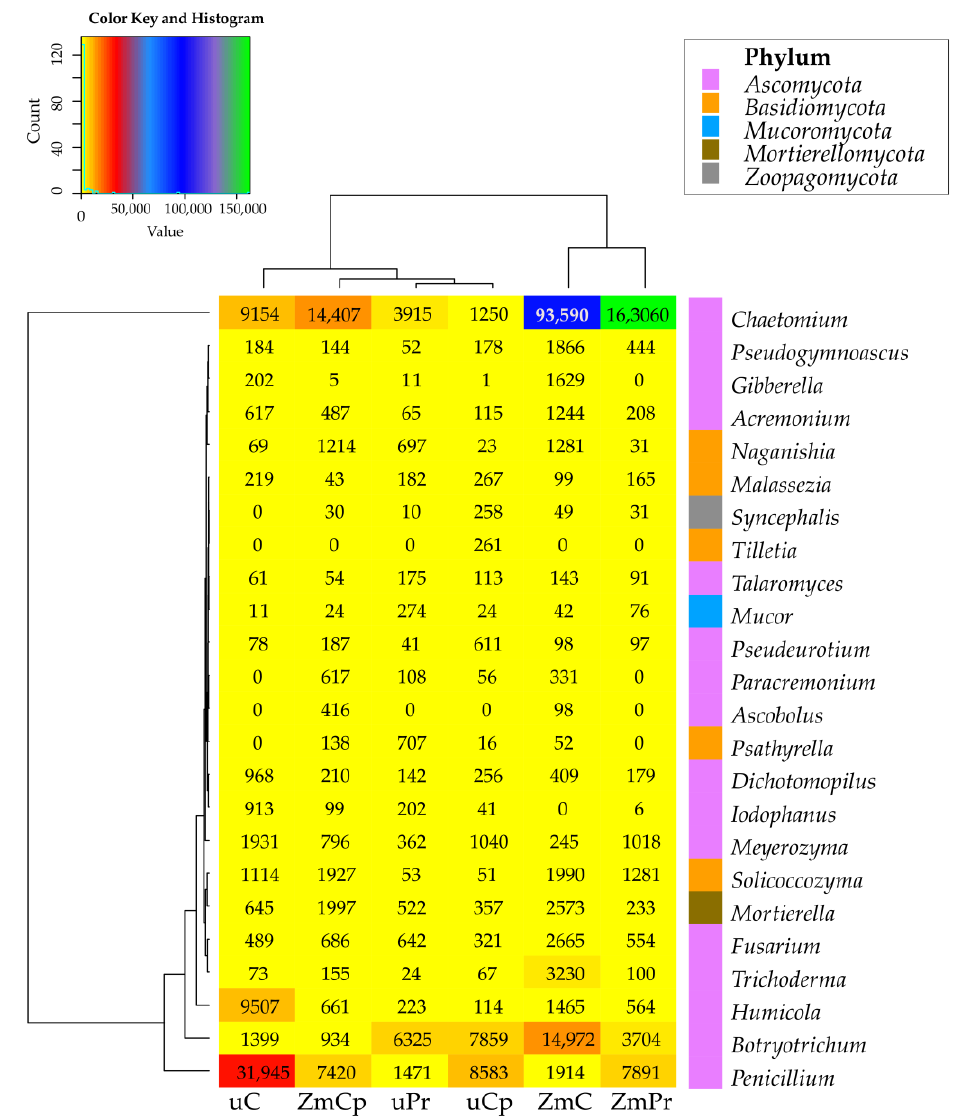
Figure 10. The relative abundance of the dominant type of fungus in the soil. uC — contaminated unsown soil; uPr — sown soil contaminated with permethrin; uCp — sown soil contaminated with cypermethrin; ZmC — uncontaminated soil sown with Zea mays ; ZmPr — soil sown with Zea mays contaminated with permethrin; ZmCp — soil sown with Zea mays contaminated with cypermethrin. The Venn diagram showed that, regardless of permethrin and cypermethrin appli- cation, the core mycobiome of both bare soil and soil cropped with Zea mays included fungi from the genera: Acremonium , Botryotrichum , Chaetomium , Dichotomopilus , Fusarium , Humicola , Malassezia , Meyerozyma , Mortierella , Mucor , Naganishia , Penicillium , Pseudeurotium , Pseudogymnoascus , Solicoccozyma , Talaromyces , and Trichoderma (Figure 11). The dominant fungi identified in the bare unsown soil not contaminated with insecticides turned out to be representatives of isolates of Penicillium (isolate SH1692798.08FU, SH2189995.08FU, New Reference OTU273) and Humicola (SH1615600.08FU), but in the bare unsown soil exposed to the pressure of permethrin and cypermethrin, the best conditions for develop- ment were offered to Penicillium (SH1533734.08FU), and in the cropped soil, to Penicillium (SH1692798.08FU, SH1533734.08FU) and Trichocladium (SH1615601.08FU) (Figure